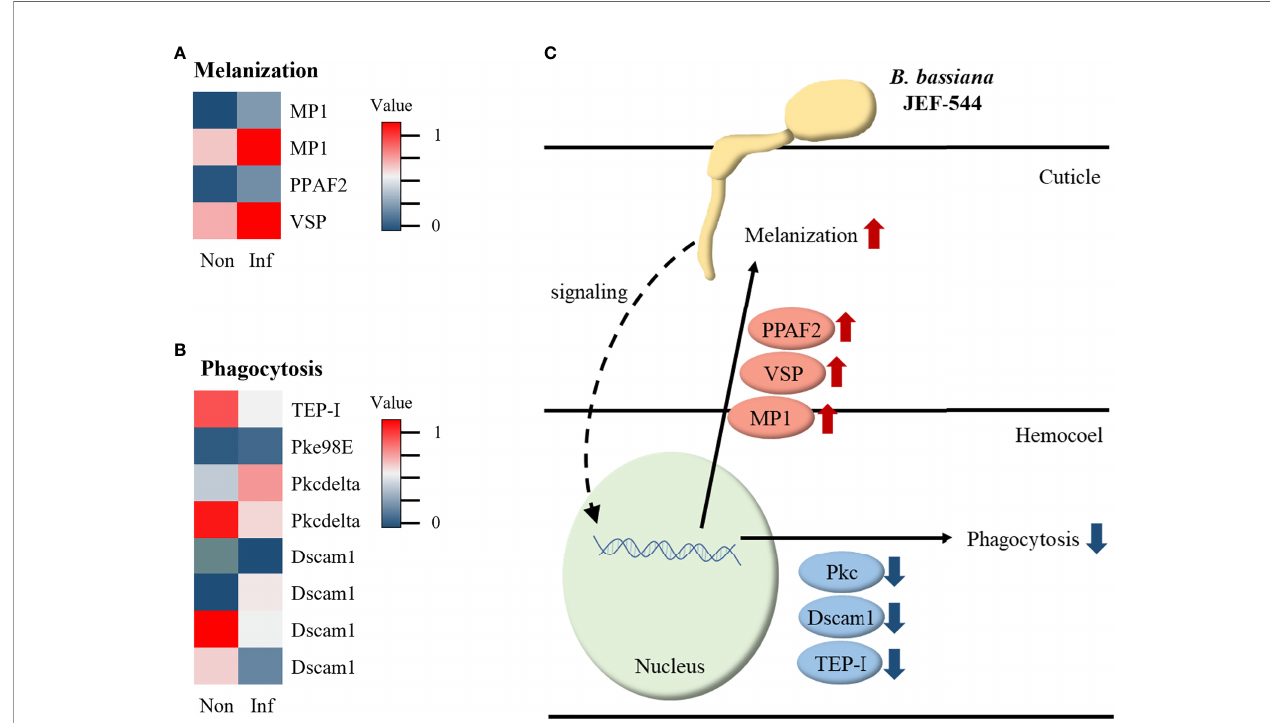
FIGURE 6 | Expression of immune-related genes in infected aphid. (A) Heatmap of melanization-related genes with expression level, (B) Heatmap of phagocytosis- related genes with expression level and (C) Summary of immune response in JEF-544-infected